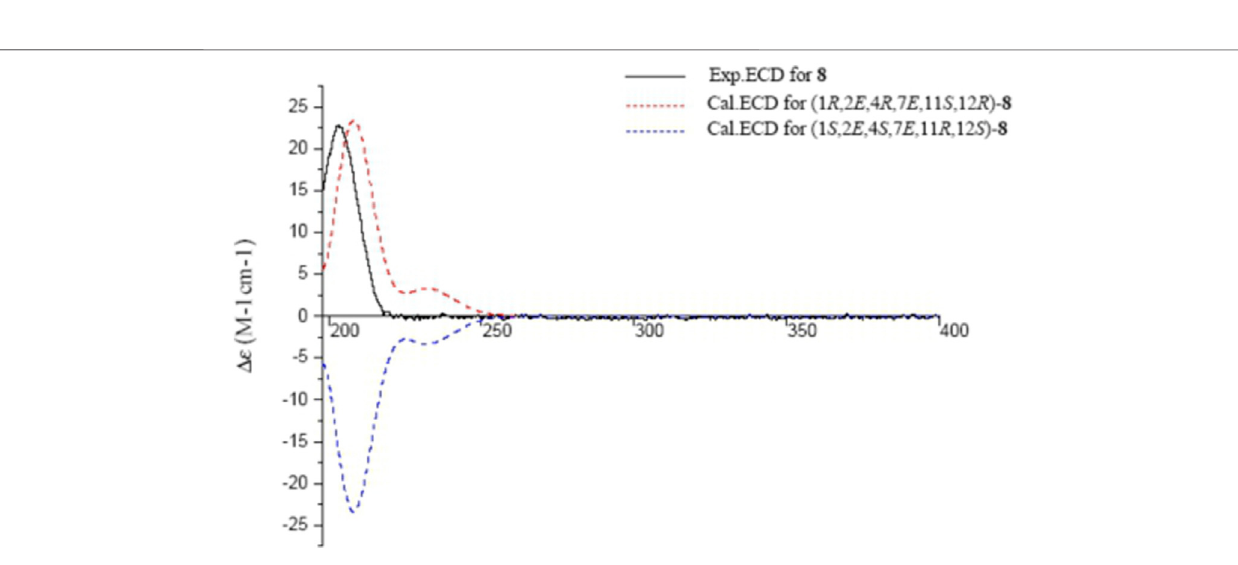
FIGURE9| Experimental and calculatedECDspectraof 8 and its enantiomer(red and bluecalculatedat the B3LYP/6 – 311++G (2d,p)//B3LYP/6 – 31+G (d, p )level in CH 3 OH; black, experimental in CH 3